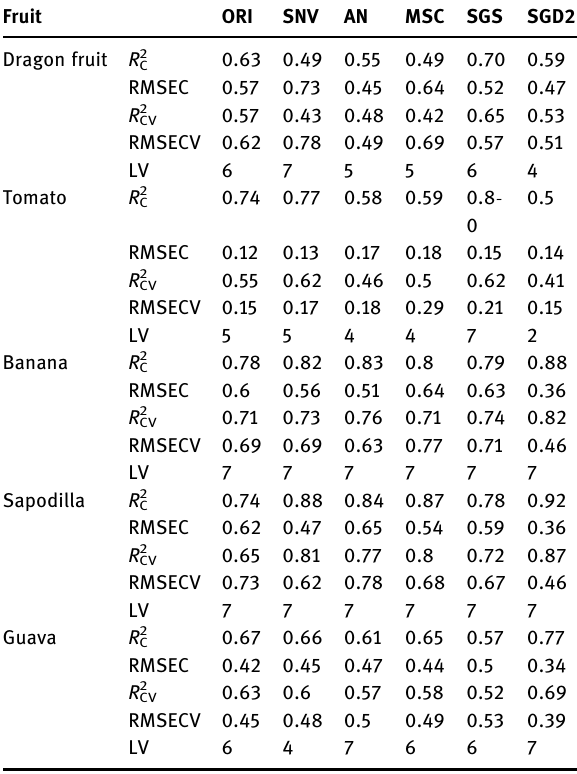
Table 4: PLSR calibration and cross - validation model performance for predicting SSC ( °Brix )